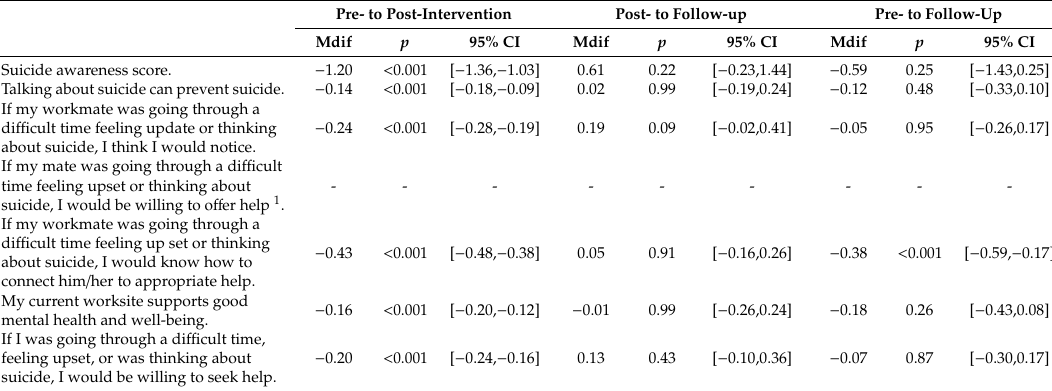
Table 2. Linear mixed-e ff ect model post-hoc analyses on time for suicide awareness. Pre- to Post-Intervention Post- to Follow-up